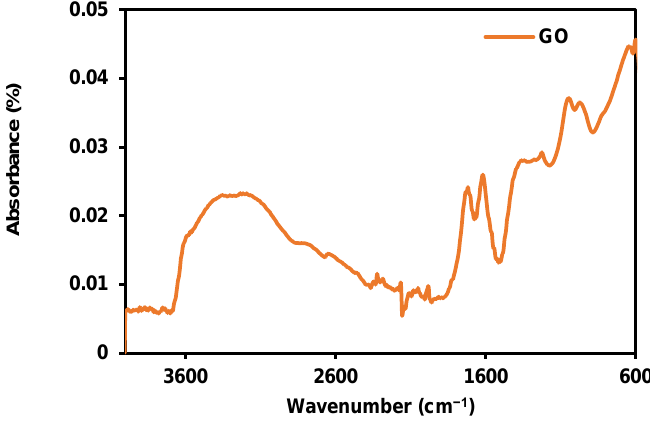
Figure 2. Fourier-transform infrared spectroscopy (FT–IR) of synthesized graphene oxide (GO).